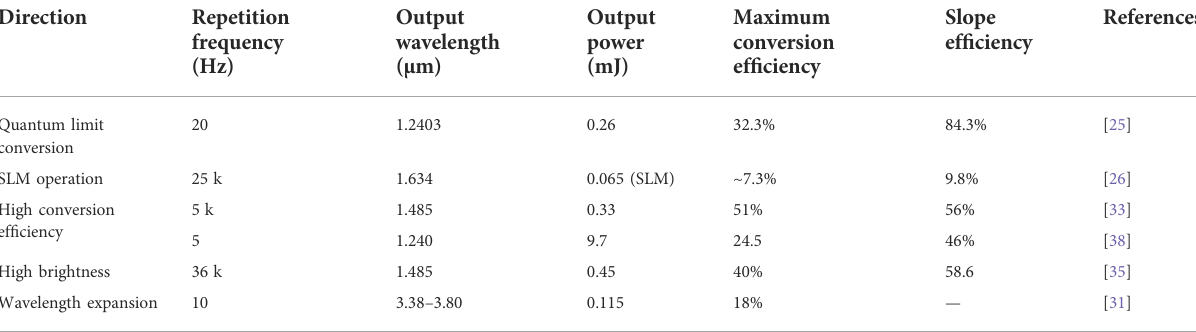
TABLE 7 The representative results of ns-pulsed